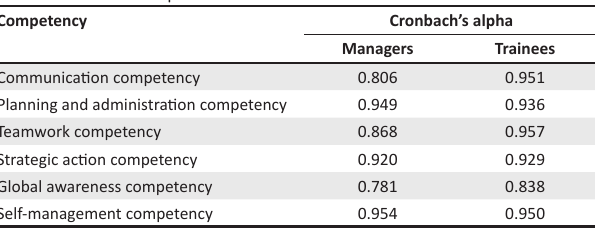
TABLE 2: Cronbach’s alpha.